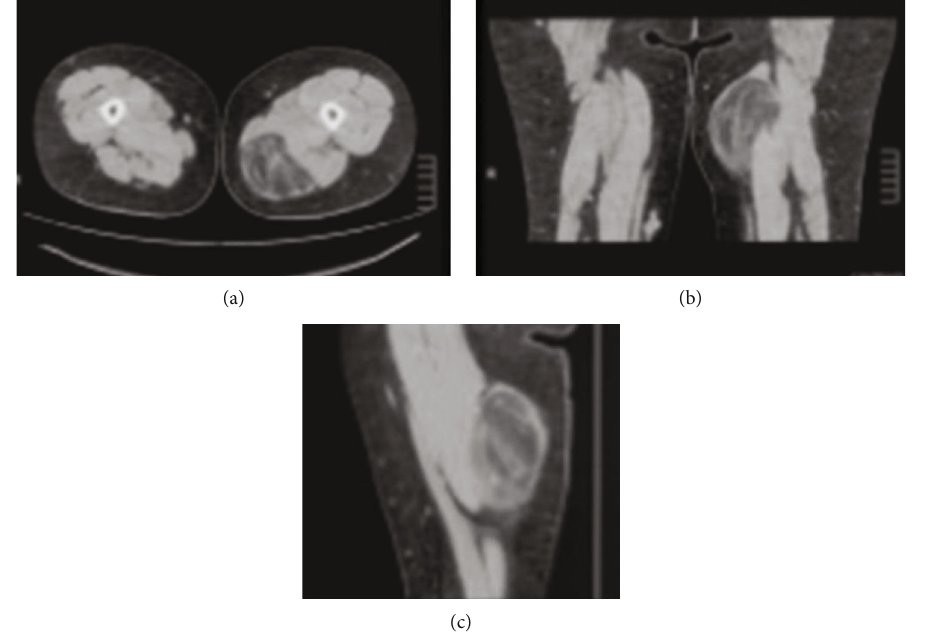
Figure 2: Computed tomography (CT) scan demonstrated 11x 8 x 7 cm , in verticalx transverse x APdiameter of well-de fi ned, fatty lesion with thick streak fi brous tissue at the right posteromedial of thigh: (a) axial view, (b) coronal view, and (c) sagittal